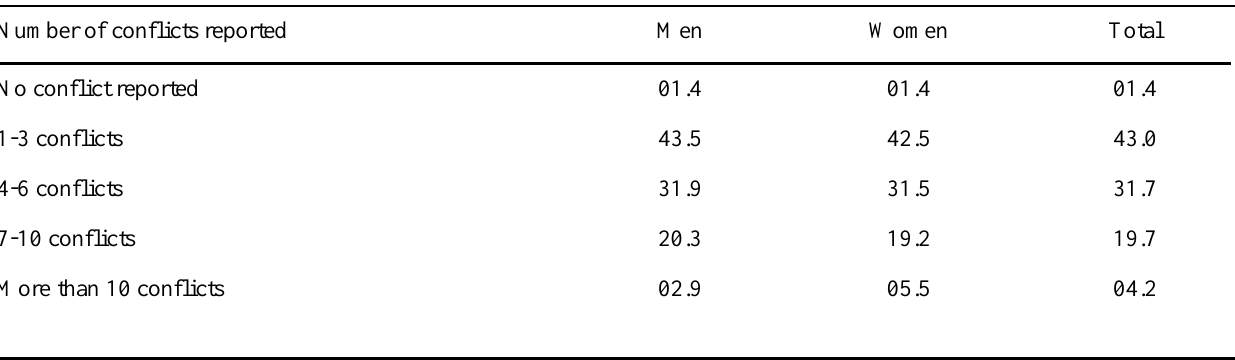
Table 2. Percentage distributions of farmers by number of natural resources management conflicts reported